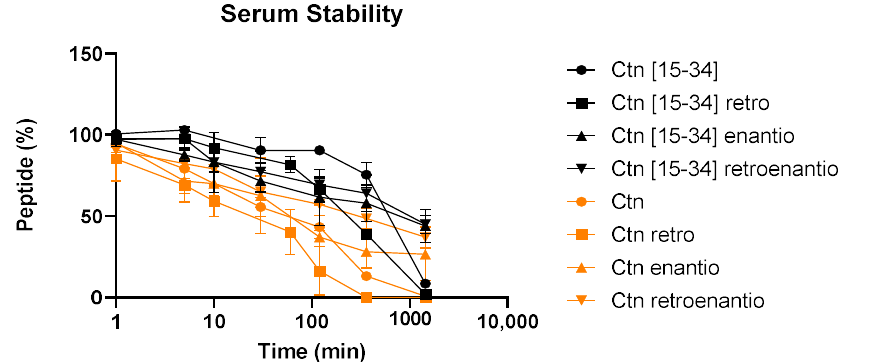
Figure 5. Stability of Ctn and Ctn[15-34] topoisomers in human serum.